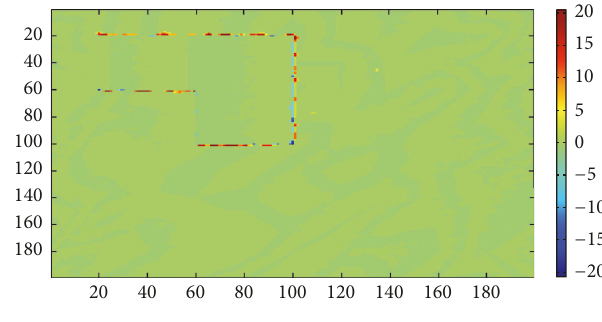
Figure 28: Imaging results.